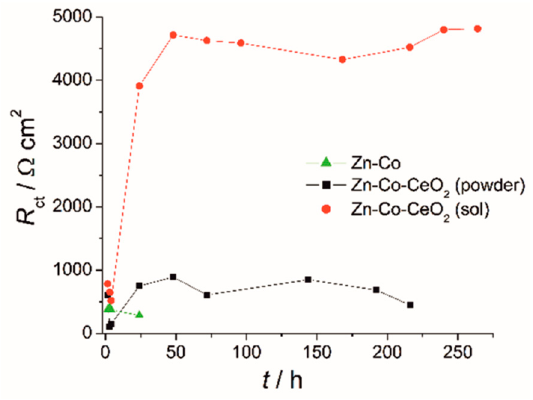
Figure 15 . Time dependence of charge–transfer resistance for Zn-Co and Zn-Co-CeO 2 coatings during exposure to 3 wt % NaCl.